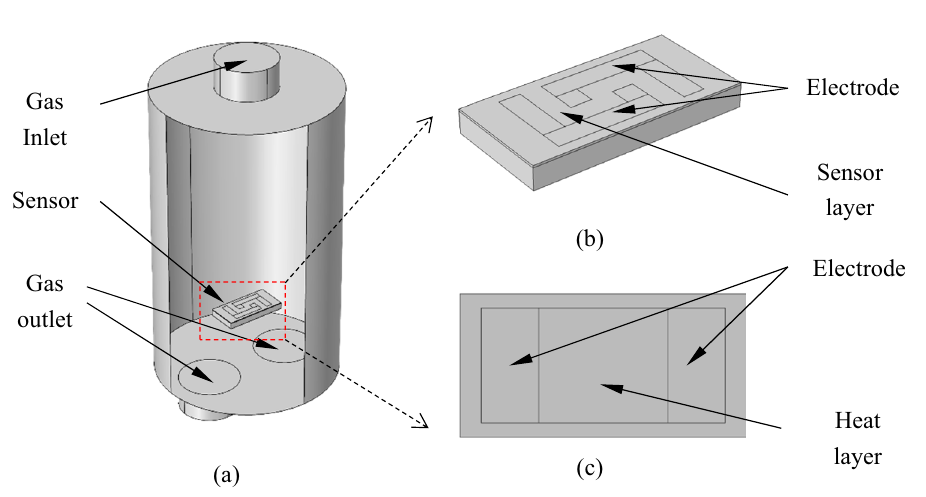
Figure 3. ( a ) Sensor and gas cavity model. ( b ) Electrode and sensor layer model on the front of the sensor. ( c ) Heating electrode model on the back of the sensor.